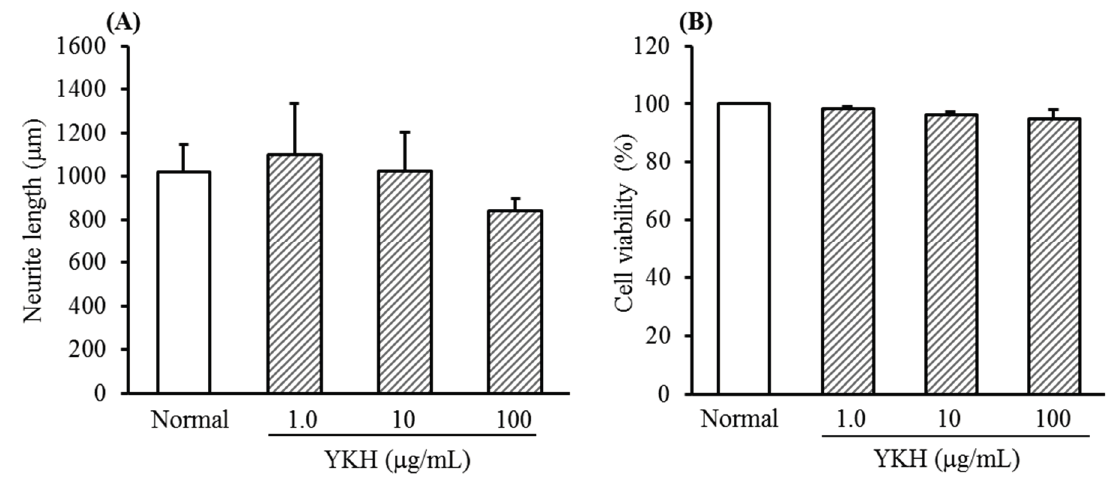
Figure 1. Changes of neurite length ( A ) and cell cytotoxicity ( B ) of yokukansankachimpihange (YKH) on cultured DRG neurons in absence of NGF. Values are the means ± S.E.M. of triplicate or quadruplet